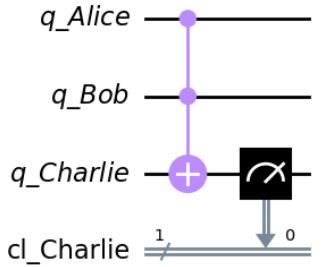
Figure 2. A simple validation circuit for the transfer request, using a CCNOT gate. The algorithm implies the existence of a dedicated quantum channel, which links Alice’s and Bob’s request qubits ( q_Alice and q_Bob ) to Charlie’s qubit ( q_Charlie ), which is a generic party, randomly selected as validator.